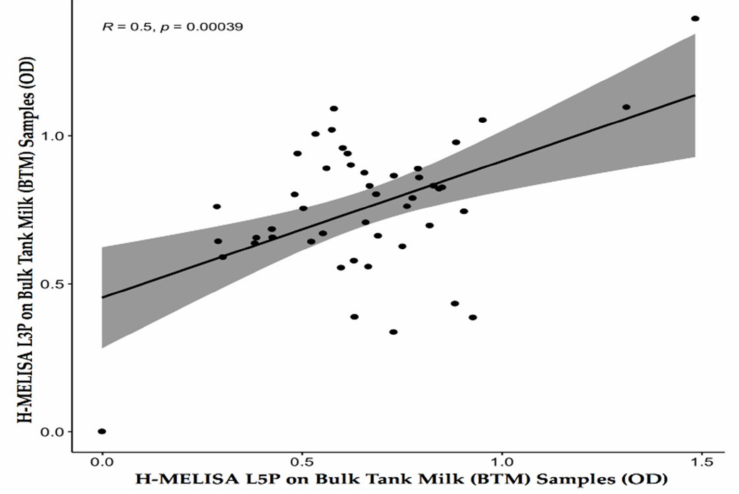
Figure 1. Pearson correlation test between the two H-MELISA analyses via the two MAP-derived lipopeptides of L3P and L5P on 47 bulk-tank-milk (BTM) samples ( r [degree of freedom = 45] = 0.5, p =